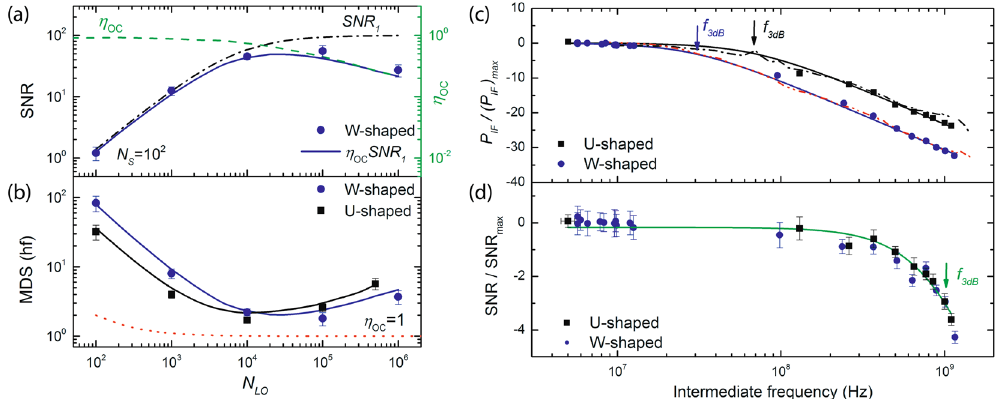
Figure 5. Measurement of the SNSPD performance as coherent detector. Blue dots correspond to the W-shaped nanowire and black squares to U-shaped nanowire. ( a ) Measured SNR vs N LO at a constant signal N S = 10 2 . The green dashed line shows the measured dependence of η oc ( N LO ) and the black dash-dotted line represents the calculated SNR 1 with extracted data of N eff . The blue solid line is the result of multiplication of η oc ( N LO ) and SNR 1 ( b ) Minimum detectable signal (MDS) in terms of single photons vs N LO . The red dotted line shows the MDS for ideal shot noise limited detector ( c ) Measured IF bandwidth for both types of detectors. The dash- dotted lines show the Fast Fourier transform of a pulse detector. The fitted values are represented with solid lines and the arrows indicate the IF frequency f 3dB at which power decreases in two times. ( d ) Noise bandwidth vs f IF . The fitted values are represented with the green solid line and the arrows indicate the IF frequency f 3dB at which SNR decreases in two